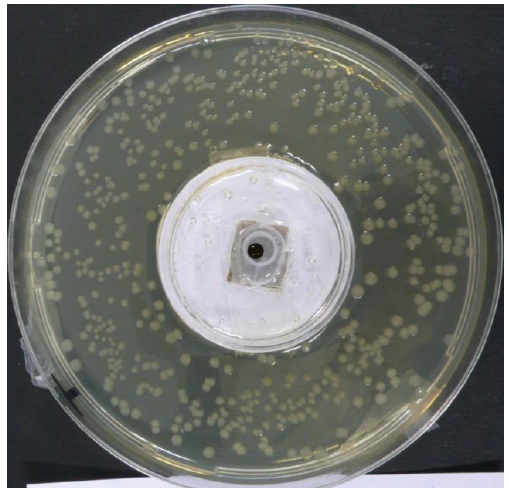
Figure 3. Detection of gaseous indole above an E. coli culture on agar media (LB agar or DEV Tryptophan agar). Photo of the experimental set-up: the sensor is deposited on the central dish filled with CaCl and surrounded by the bacterial culture in the Petri dish. 2